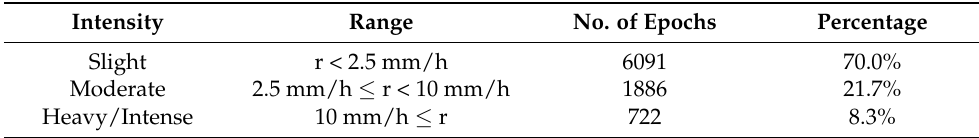
Table 2. Definition of different precipitation intensities, as well as the number of epochs corresponding to each intensity and their percentages of